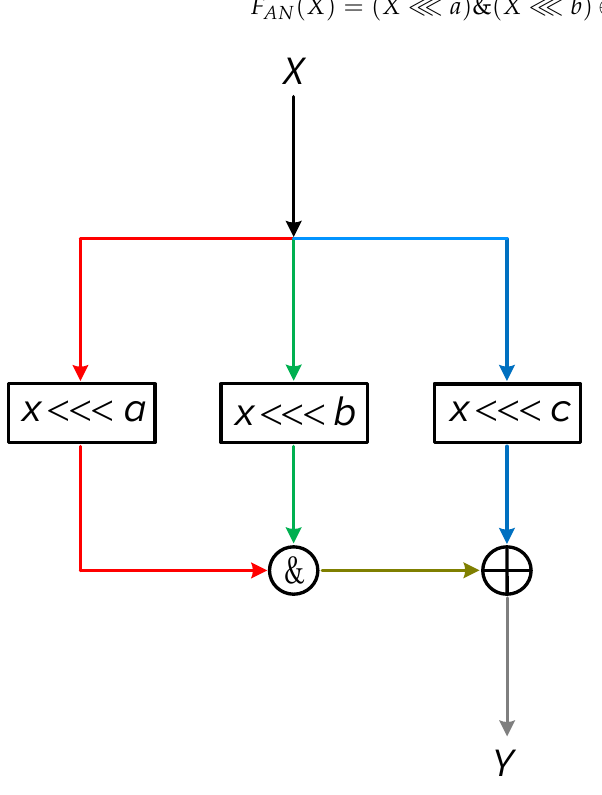
Figure 3. The flow of F AN